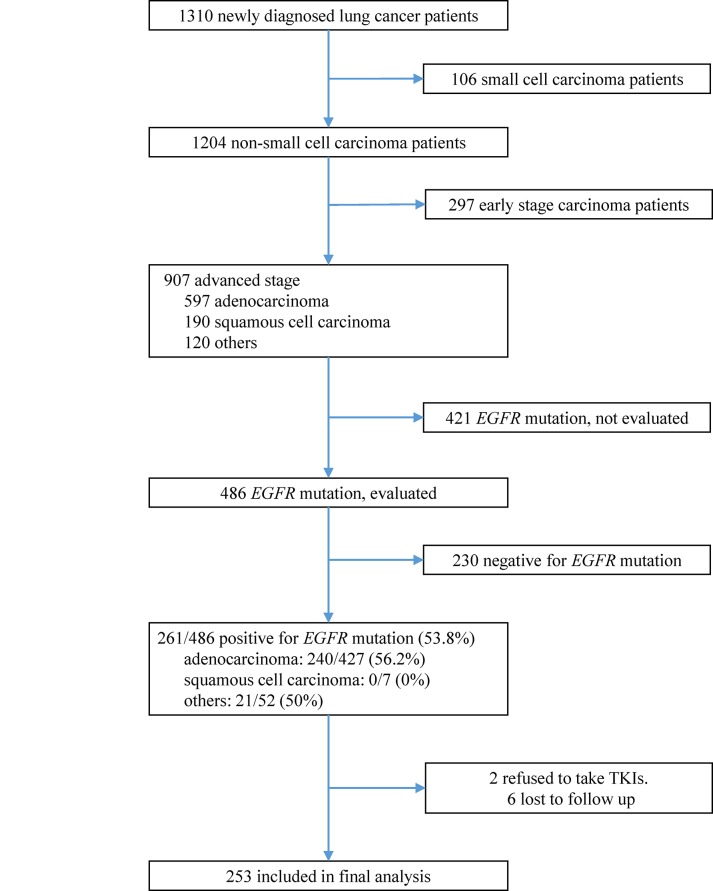
Inclusion, screening, and group assignment of patients.Among 1310 non-small-cell lung cancer patients diagnosed between January 2011 and October 2013, 253 patients were included into final analysis.